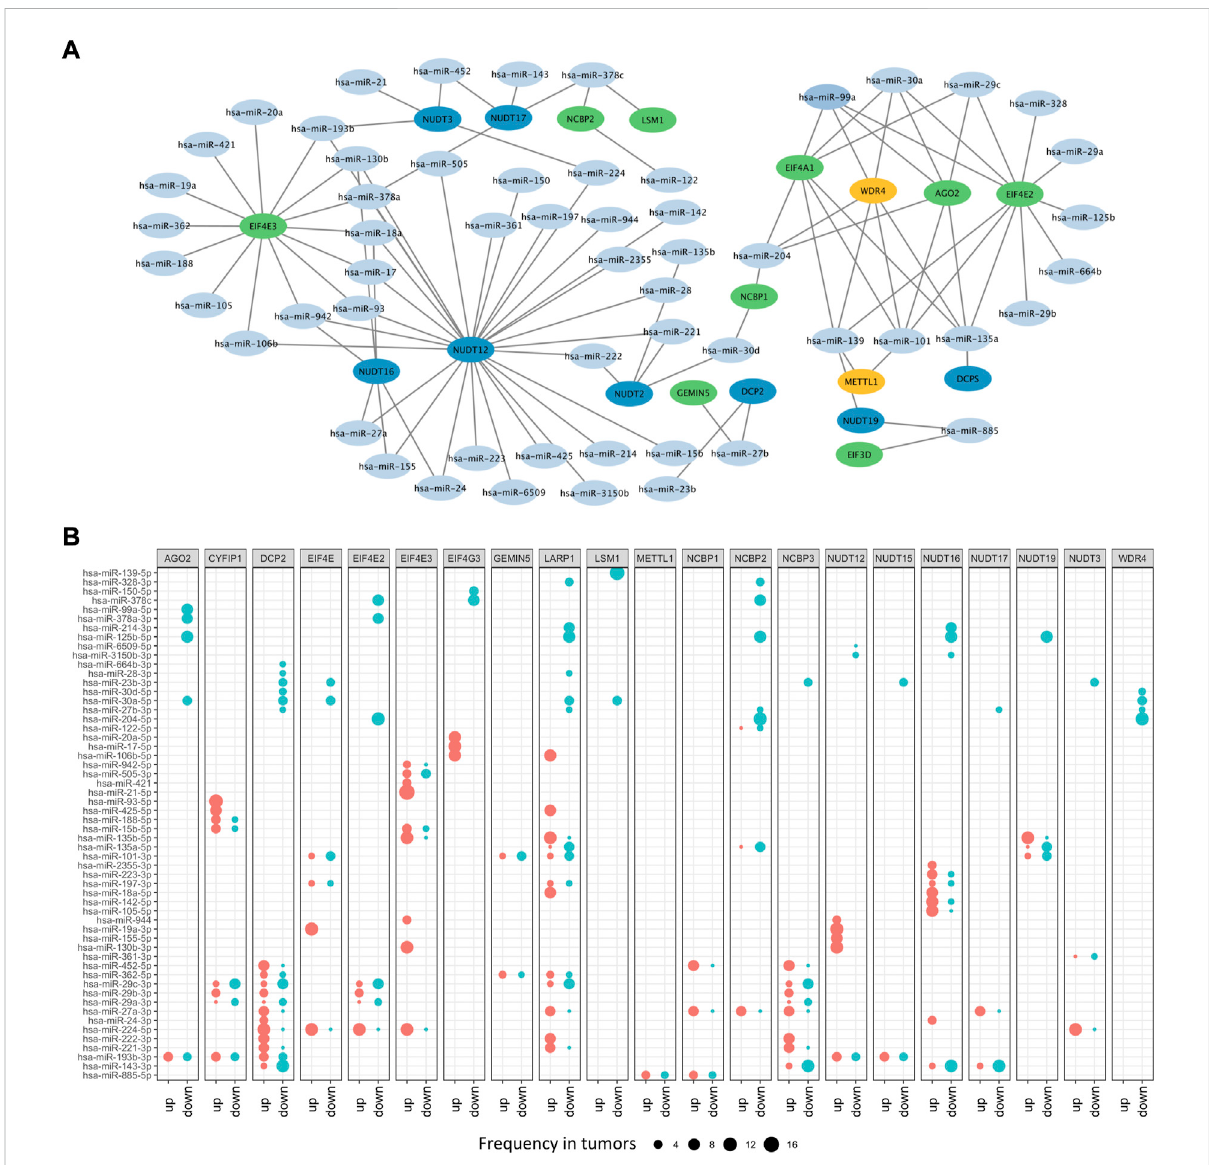
FIGURE 4 The microRNA network of m7G regulators. (A) The miRNA-mRNA network of m7G regulators. (B) The differential expressed m7G regulators- related